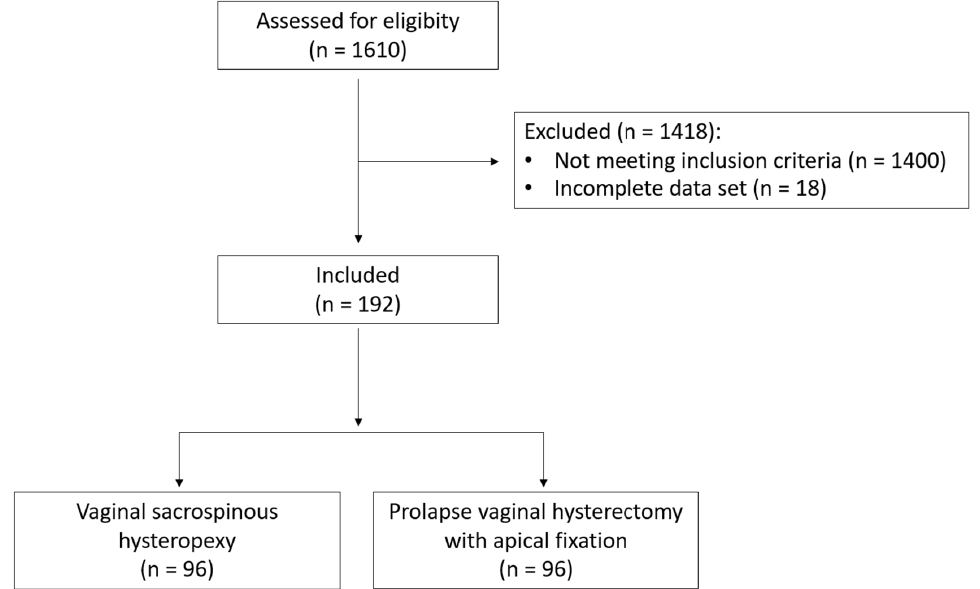
Figure 1. Flow of patients through the study.